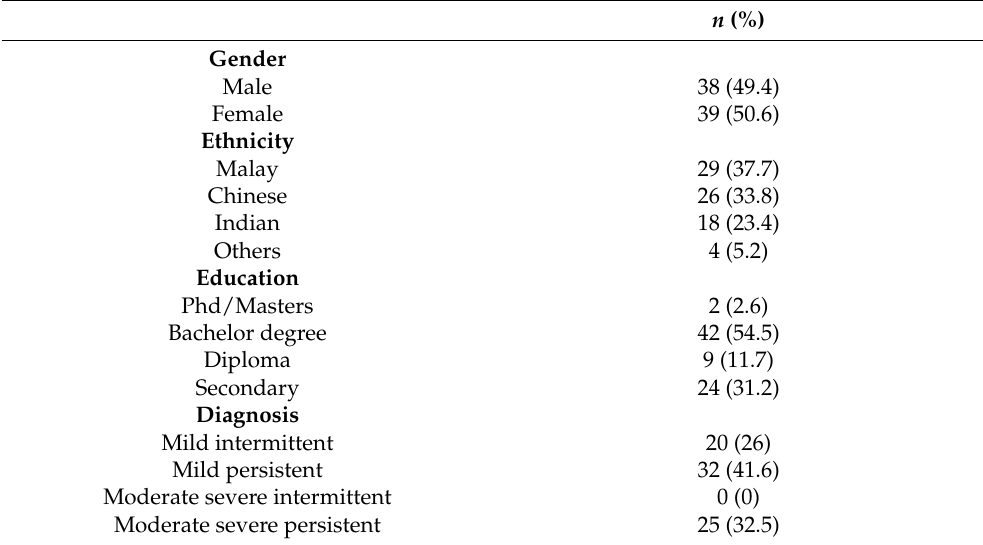
Table 2. Socio-demographic characteristic of